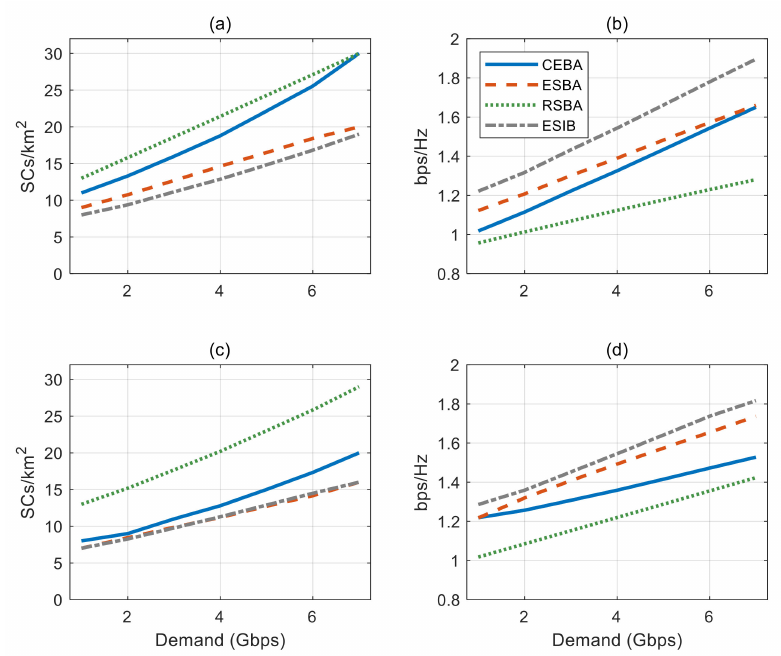
Figure 2. Performance comparison in terms of number of SCs (#SCs) and spectral e ffi ciency for di ff erent MC densities and tra ffi c demands. ( a ) #SCs for 2 MCs / km 2 ; ( b ) Spectral e ffi ciency for 2 MCs / km 2 ; ( c ) #SCs for 3 MCs / km 2 ; ( d ) Spectral e ffi ciency for 3 MCs / km 2